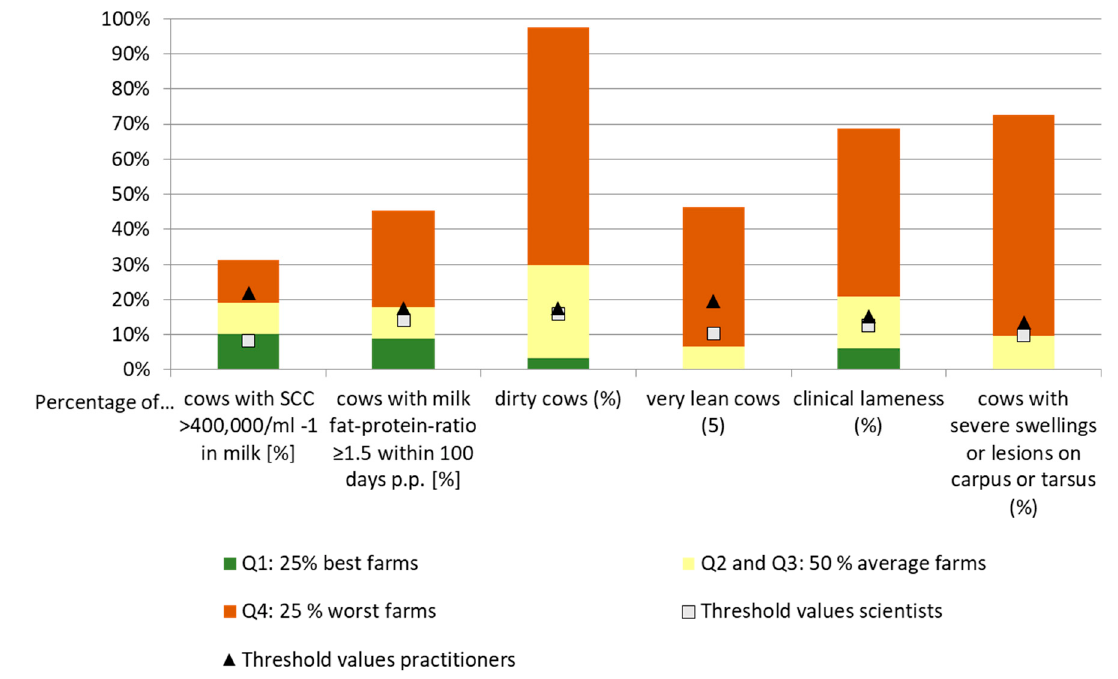
Figure 3. Normative versus status quo-based threshold values: A comparison of the normative values of scientists ( n = 12–17) and practitioners ( n = 8–9) with the results of the on-farm survey ( n = 115).